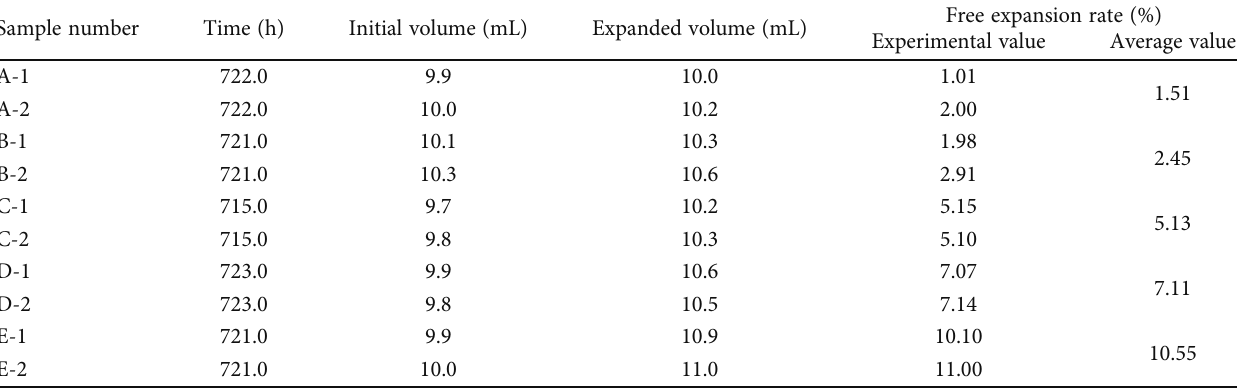
Table 3: Test results of free expansion